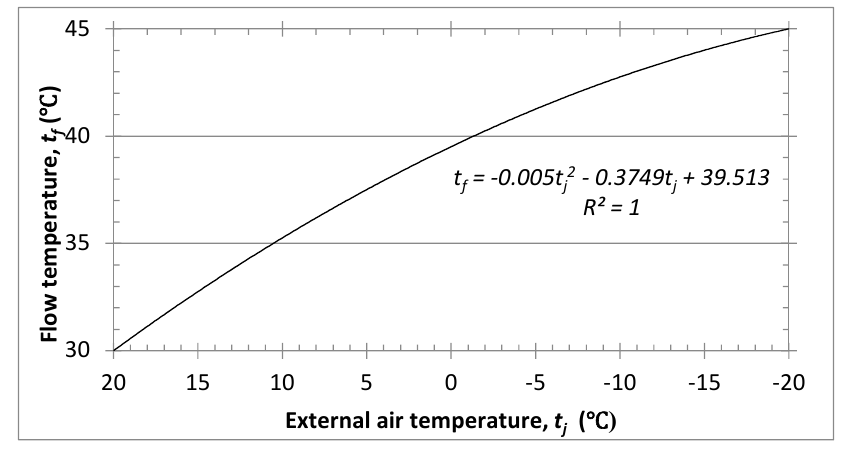
Figure 2. Heating curve selected in a weather compensator [29].